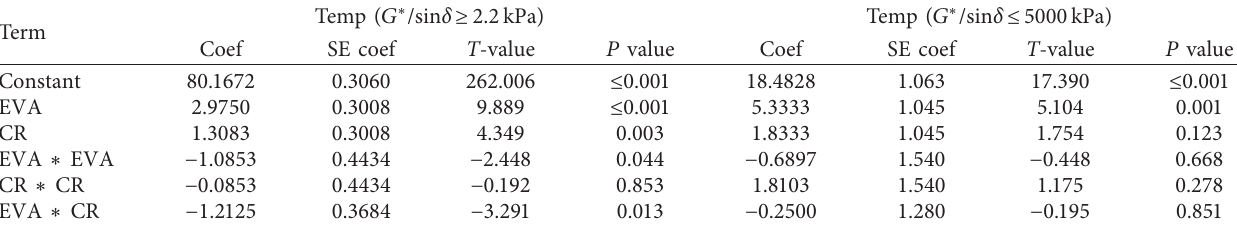
Table 6: Values of regression coefficients calculated for DSR tests.